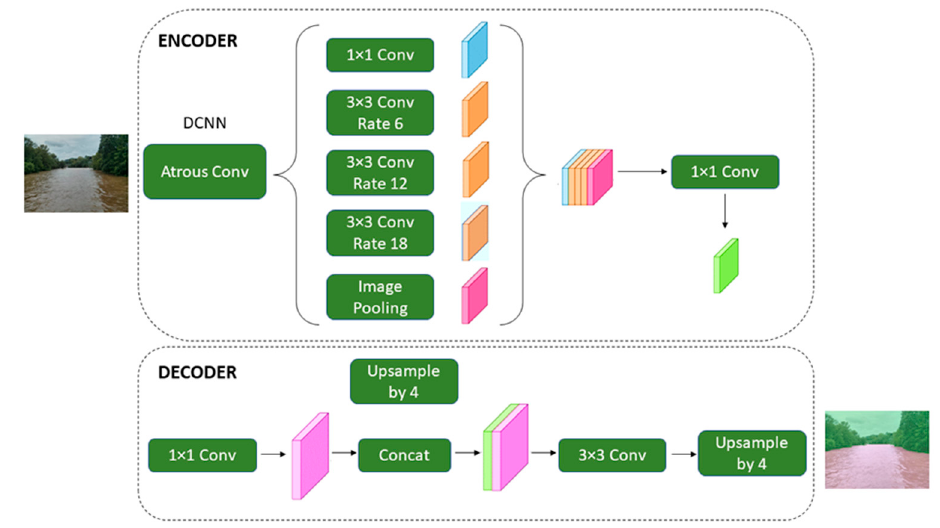
Figure 2. An illustration of DeepLabv3+ architecture